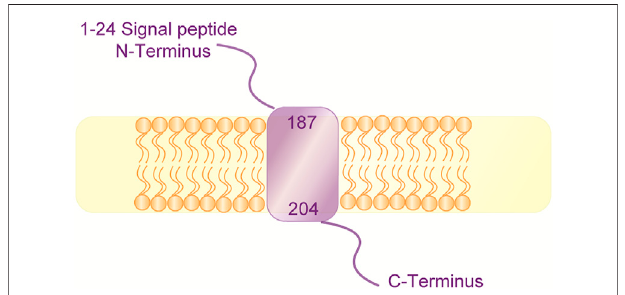
FIGURE 2 | Predictive structure of